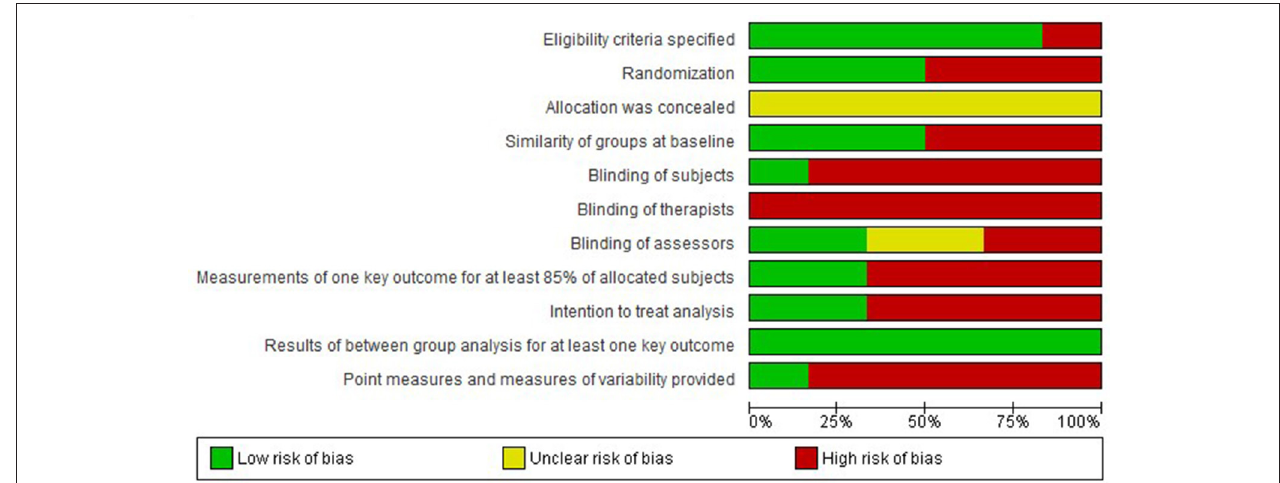
FIGURE 2 | Risk of bias graph: review authors’ judgements about each risk of bias item presented as percentages across all included studies.